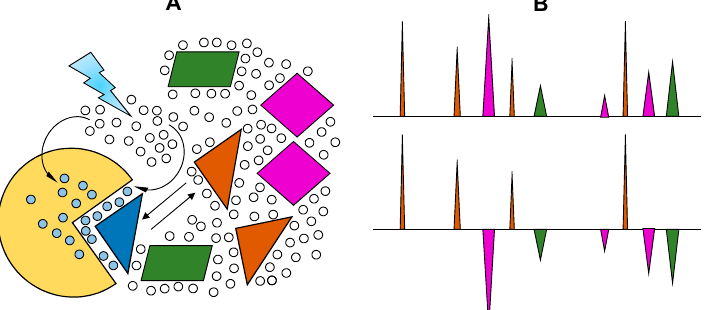
Figure 7. Schematic description of the waterLOGSY experiment. ( A ) The magnetization of the bulk water is selectively transferred, via the protein-ligand complex, to binding ligands (triangles). ( B ) Hypothetical representations of NMR spectra from a mixture (top) and from the resultant one-dimensional (1D) waterLOGSY spectrum (bottom), where binding and non-binding ligands can be straightforwardly identified. The positive-phase signals (brown peaks) are produced from binding ligands interacting with protein (blue and brown triangles) and cross-relax with protein-bound water, whose magnetization is selectively inverted. The peaks in negative-phase (green and purple peaks) come from the non-binding ligands which do not interact with inverted water molecules bound to the protein. Adapted with permission of RSC MedChemComm from NMR and molecular recognition. The application of ligand-based NMR methods to monitor molecular interactions. Unione L., Galante S., Diaz D., Cañada J., Jiménez-